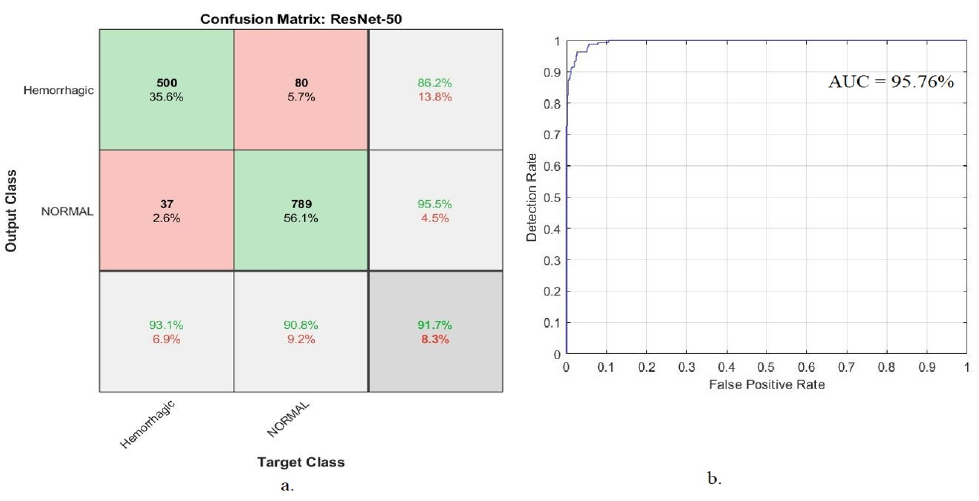
Figure 9. Performance of the ResNet-50 model for diagnosing the hemorrhage dataset. ( a ) Confusion matrix. ( b ) AUC.